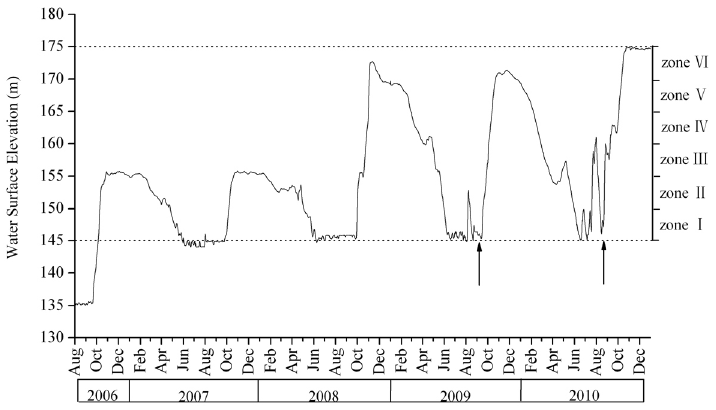
Fig 2. Water level of the Three Gorges Reservoir between August 2006 and December 2010. Data updated from [13] to include July 2009 – Dec 2010. Data originate from the daily records of the Three Gorges Dam hydrology station (http://www.ctgpc.com.cn/index.php). The vertical arrows indicated the period for field